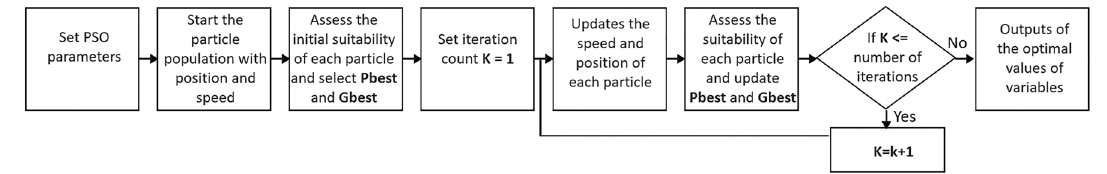
Figure 9. Flowchart of the PSO algorithm—created using PowerPoint software version Microsoft